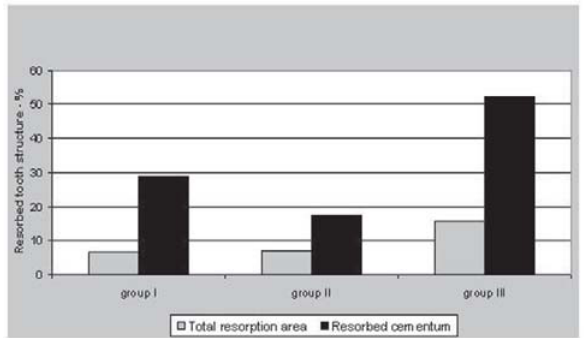
FIGURE 7- Total root resorption area and extension of cementum resorption in the different treatment groups